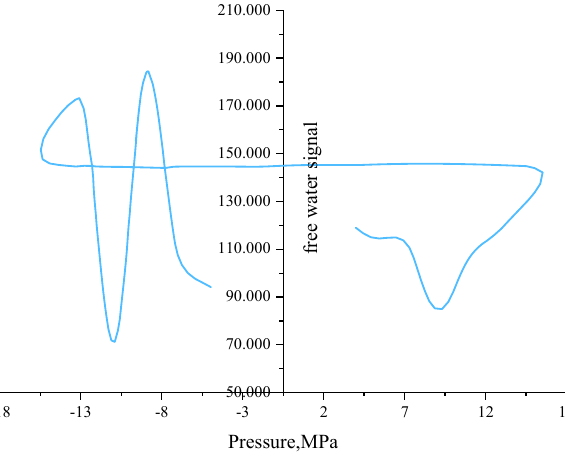
Figure 21. Core free water signal and radial compressive stress curve.